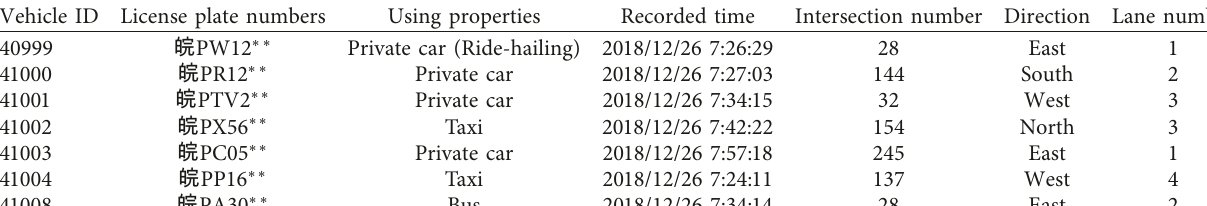
Table 3: Data on urban vehicles recorded by the traffic bayonet